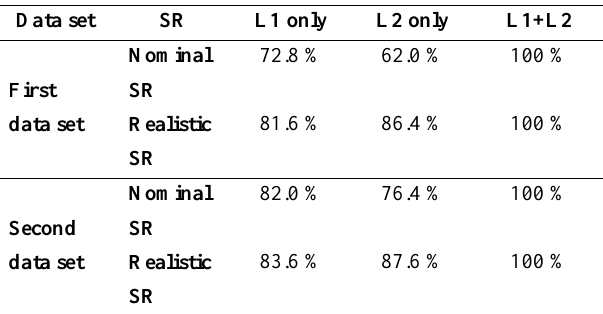
Table 2. Estimated empirical success rate (SR) for each of GPS data sets in three